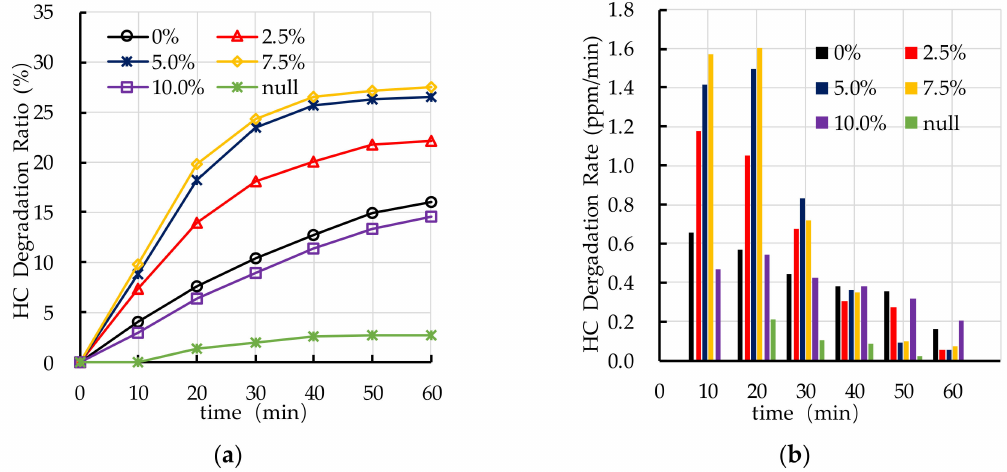
Figure 16. E ff ect of dispersant dosage on photocatalytic degradation of HC: ( a ) HC degradation ratio; ( b ) HC degradation